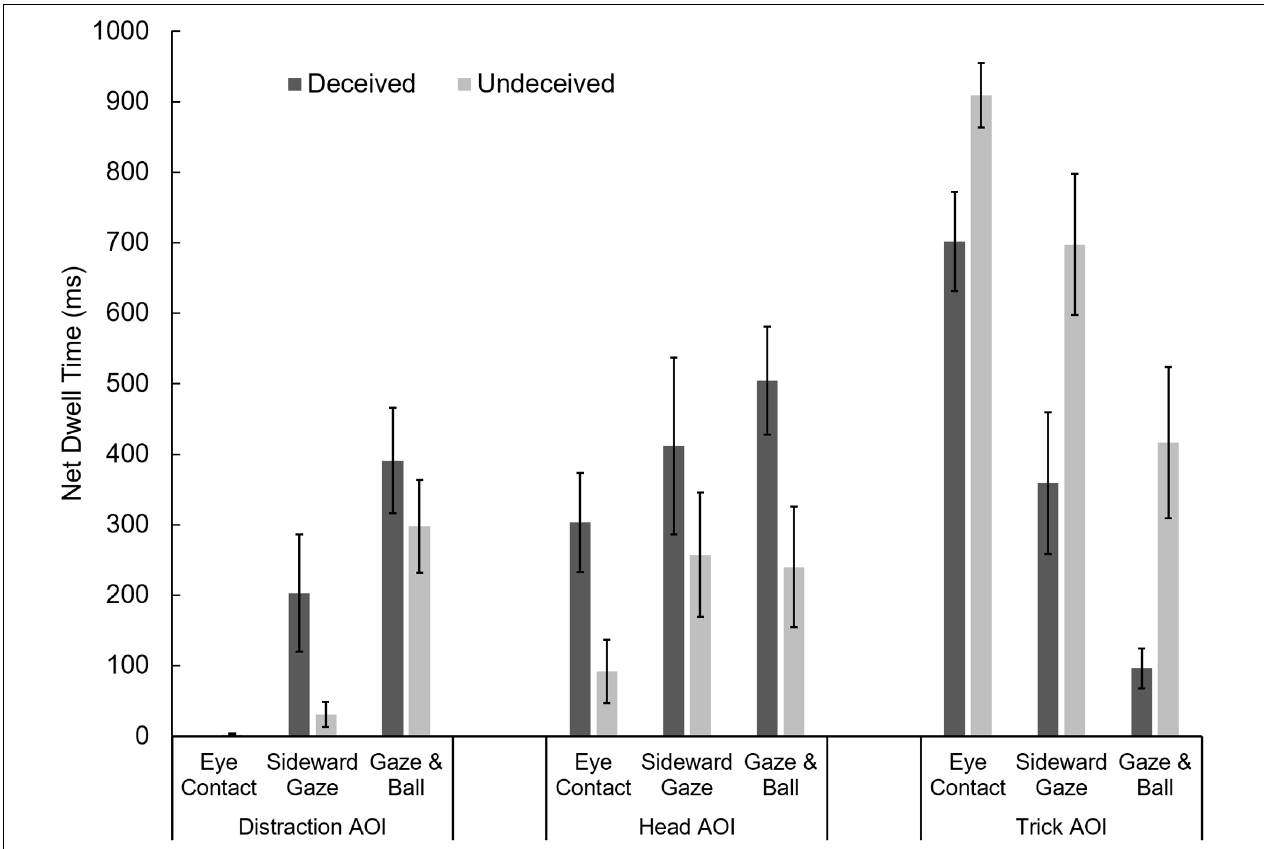
FIGURE 6 | Deceived and undeceived individuals’ net dwell time on the three AOI during the 19-to-20-s period of the first presentation of the videos in the three experimental conditions in which social misdirection was employed. Error bars denote standard errors of the mean. As noted in Figure 5 , participants did not orient their gaze toward the distraction AOI in the Eye Contact